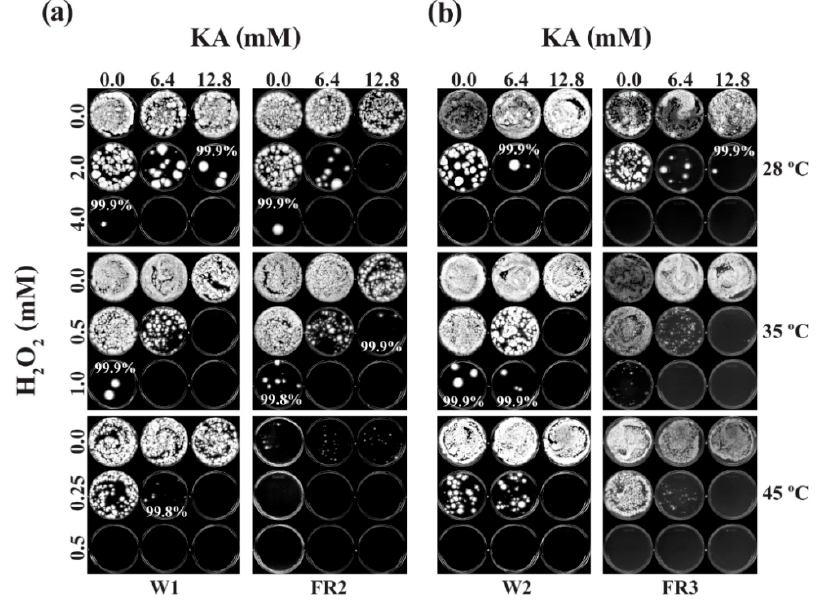
Figure 3. Chemosensitization (KA + H 2 O 2 ) test in P. expansum wild type and fludioxonil-resistant mutants at moderate (28 °C) to high (35, 45 °C) temperatures. Results shown here are determination of MFCs of antifungal agents (48 h). ( a ) W1 and FR2; ( b ) W2 and